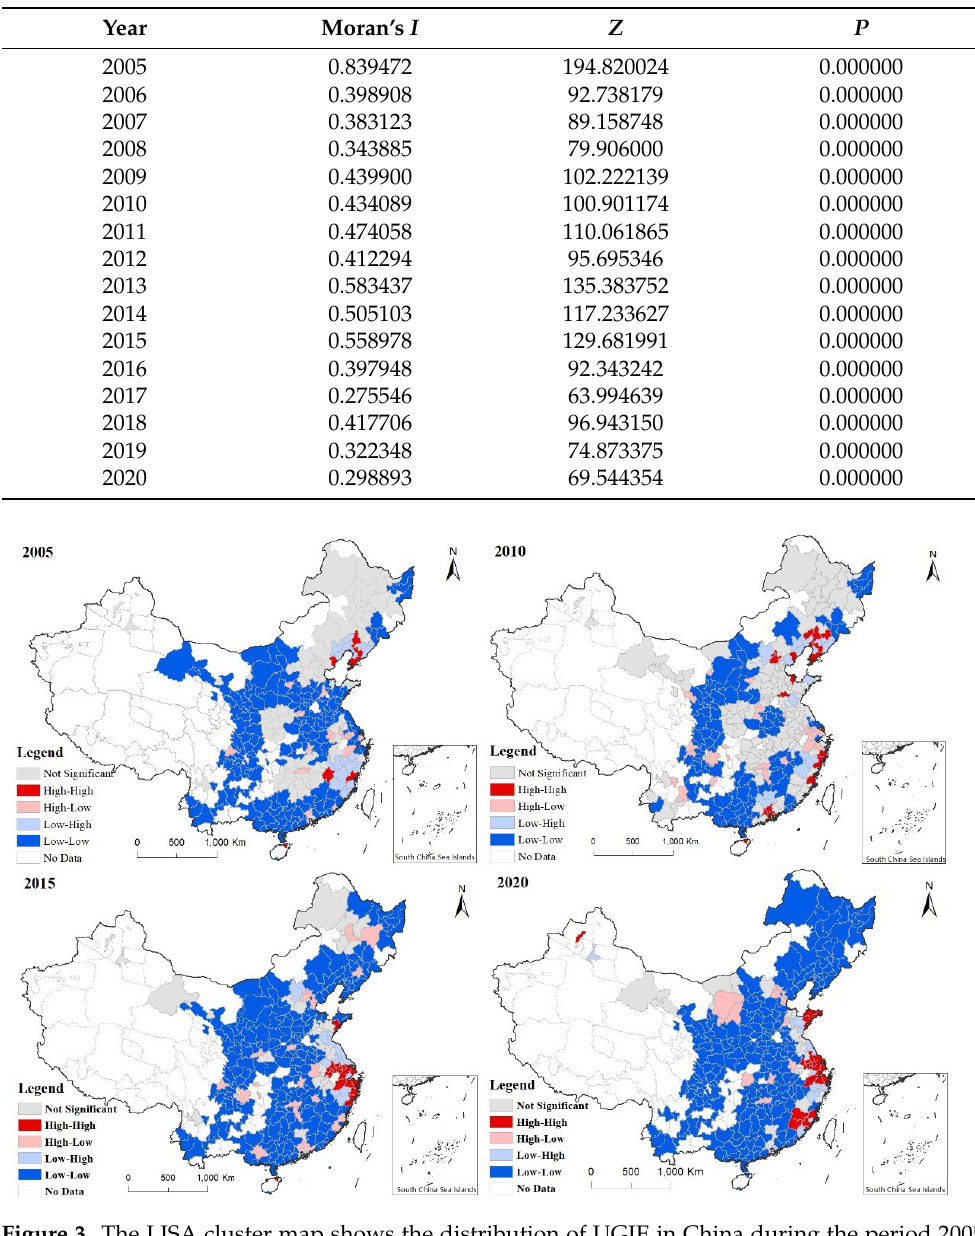
Figure 3. The LISA cluster map shows the distribution of UGIE in China during the period 2005 to 2020.